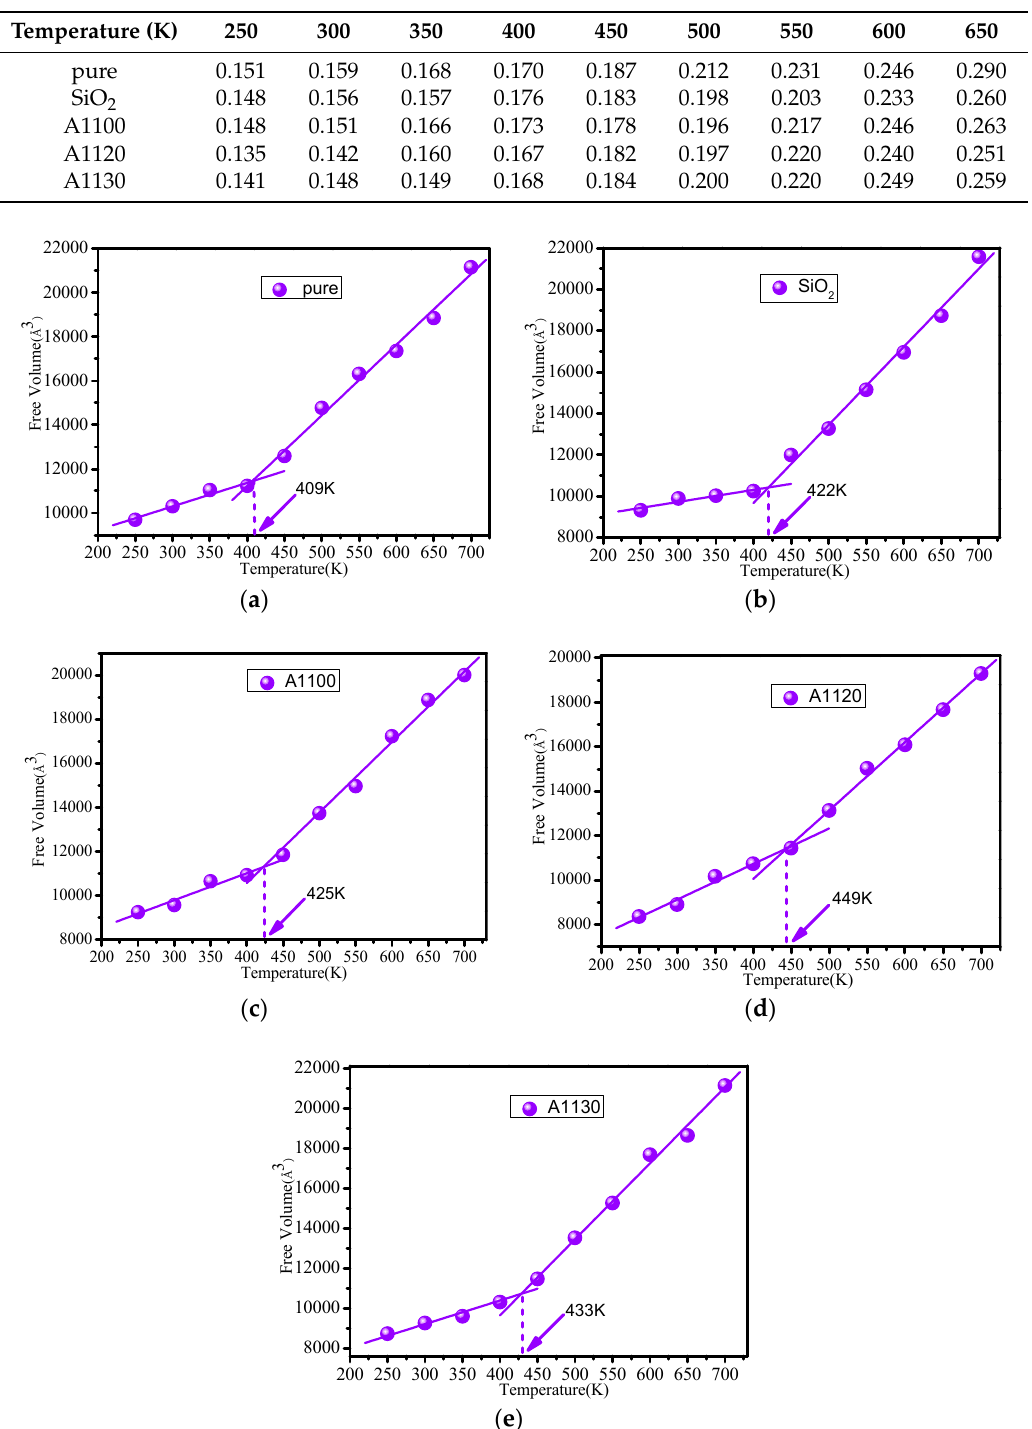
Table 1. Calculation of free volume fraction (100%).